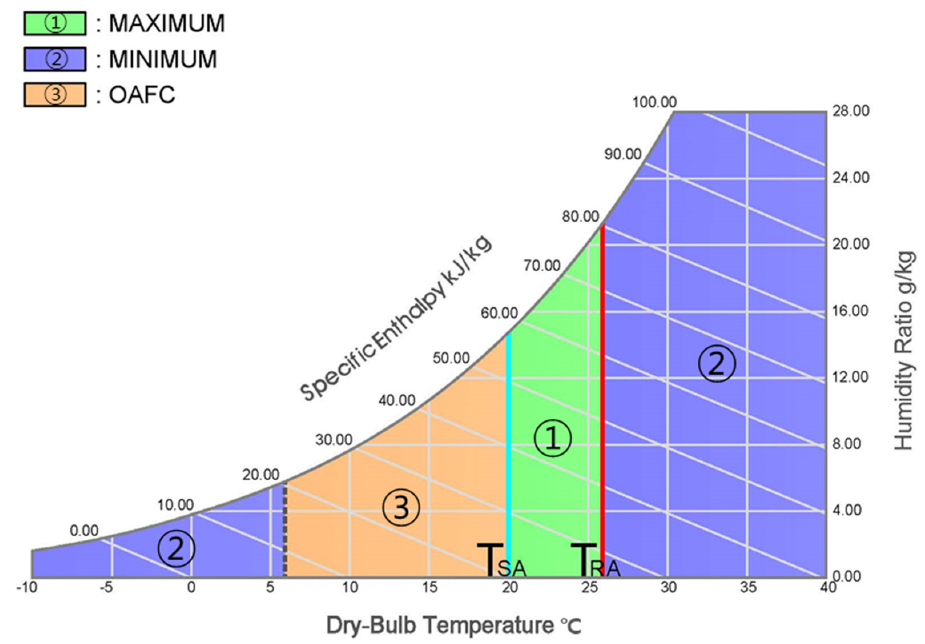
Figure 2. Differential dry-bulb temperature control method.